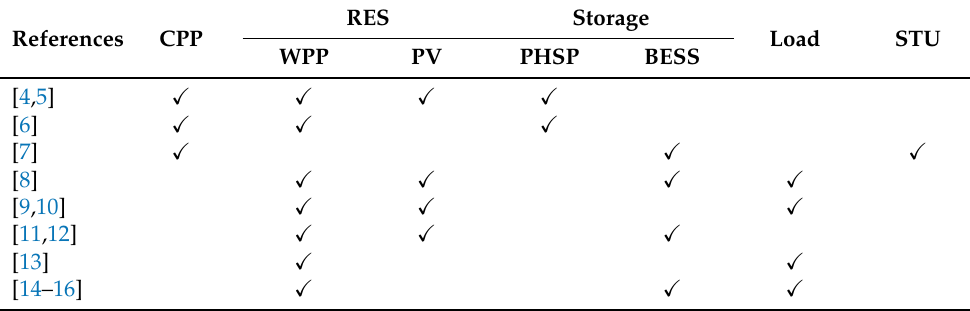
Table 1. VPP components and